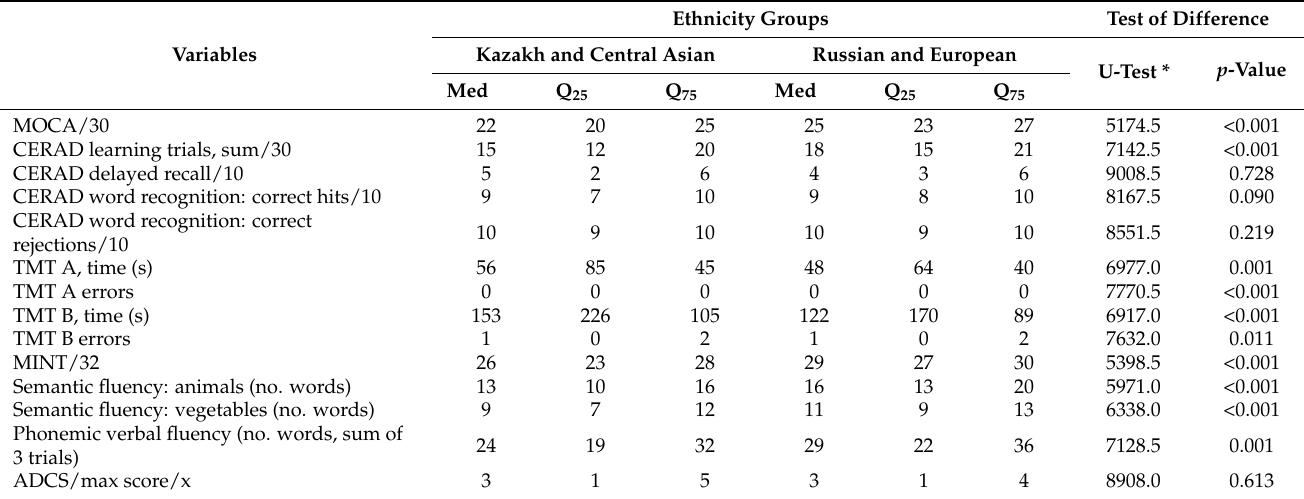
Table 5. Summary statistics for neuropsychological test scores for ethnic